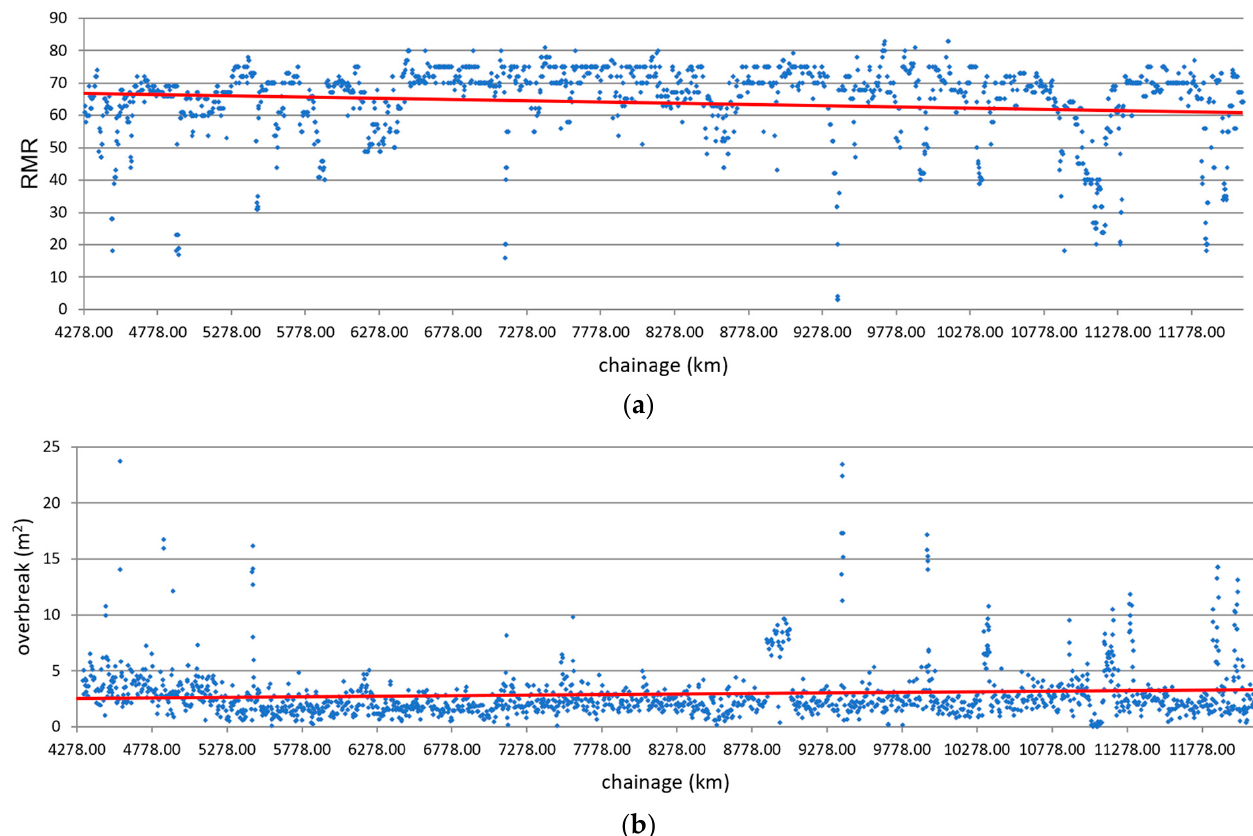
Figure 10. ( a ) RMR values along tunnel section; ( b ) overbreaks along tunnel, per meter length.